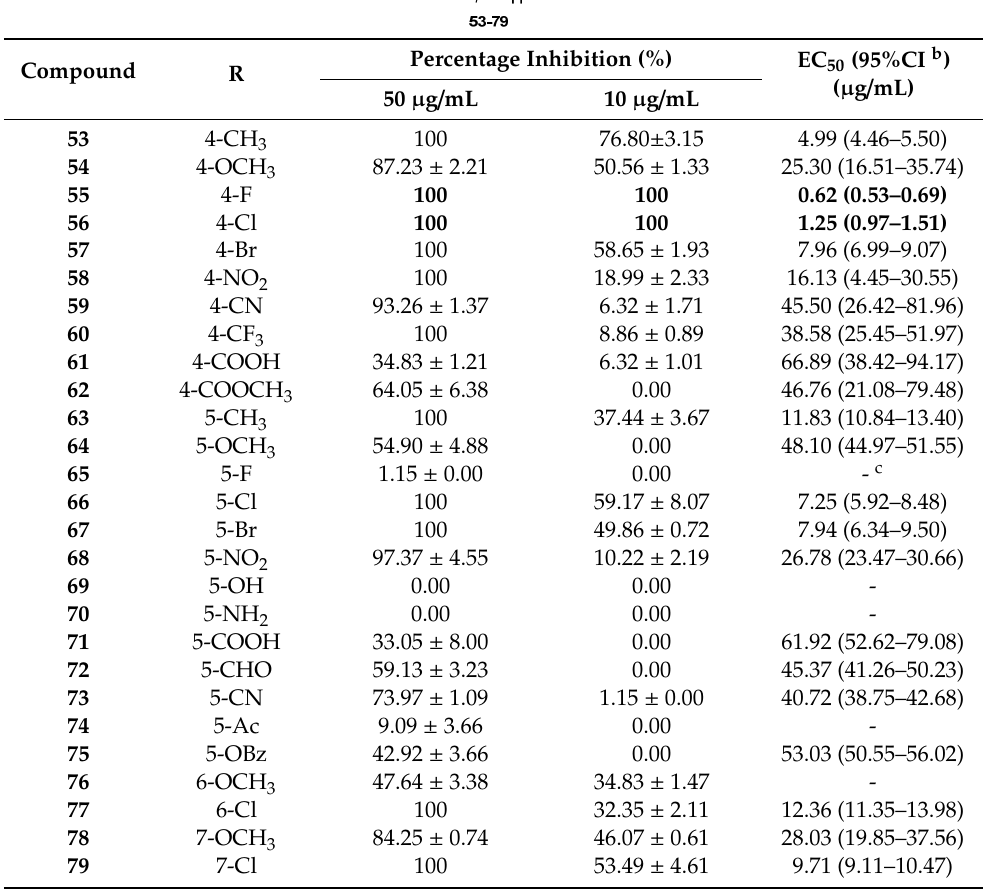
Table 3. In vitro fungicidal activity of compounds 53–79 . a